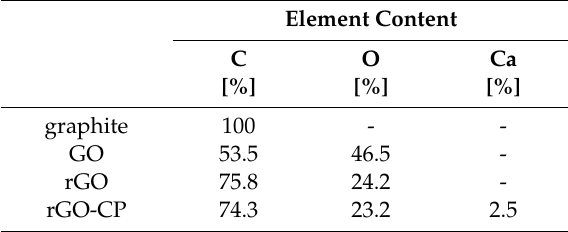
Table 1. Atomic percentage of atoms in graphene-based materials.